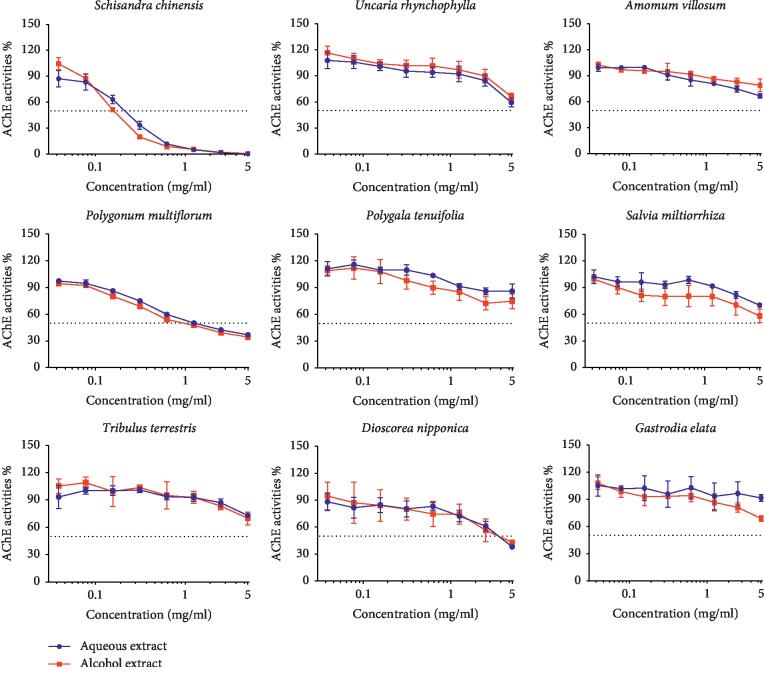
The evaluation of AChE activity of nine Chinese herbs by Ellman assay with water extraction (blue line) and alcohol extraction (red line).